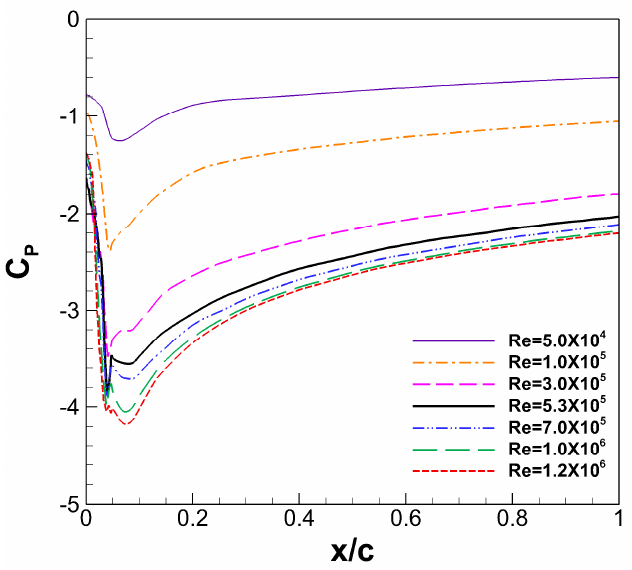
Figure 15. Pressure coefficient profiles along the vortex core at different Reynolds numbers.